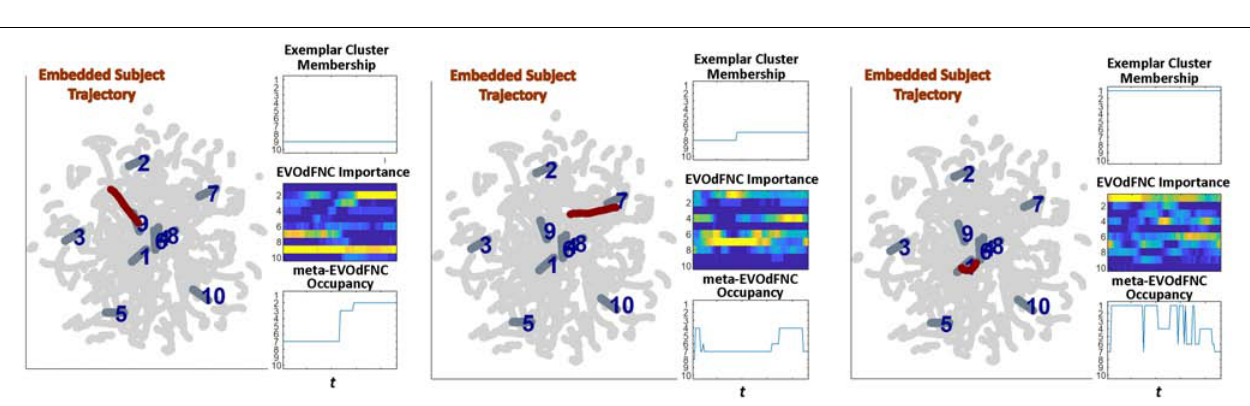
FIGURE 18 | Three examples (leftmost panel in each subfigure) showing how proximity of subject embedded trajectories ˆ γ [maroon, superimposed with the 10 linear exemplars (dark gray, labeled in dark blue) over the full embedding (light gray)] are represented in terms of (right panel in each subfigure, top row) membership of local linear approximations to ˆ γ in clusters defining each of the 10 linear exemplars; (right panel in each subfigure, middle row) the representational importance of the high-dimensional EVOdFNCs corresponding to each 2D linear exemplar in the subject’s high-dimensional dFNC trajectory (cid:48) , and (right panel in each subfigure, bottom row) the occupancy of meta-EVOdFNCs re-indexed to correspond with the EVOdFNC, which is most strongly weighted in each meta-EVOdFNC.